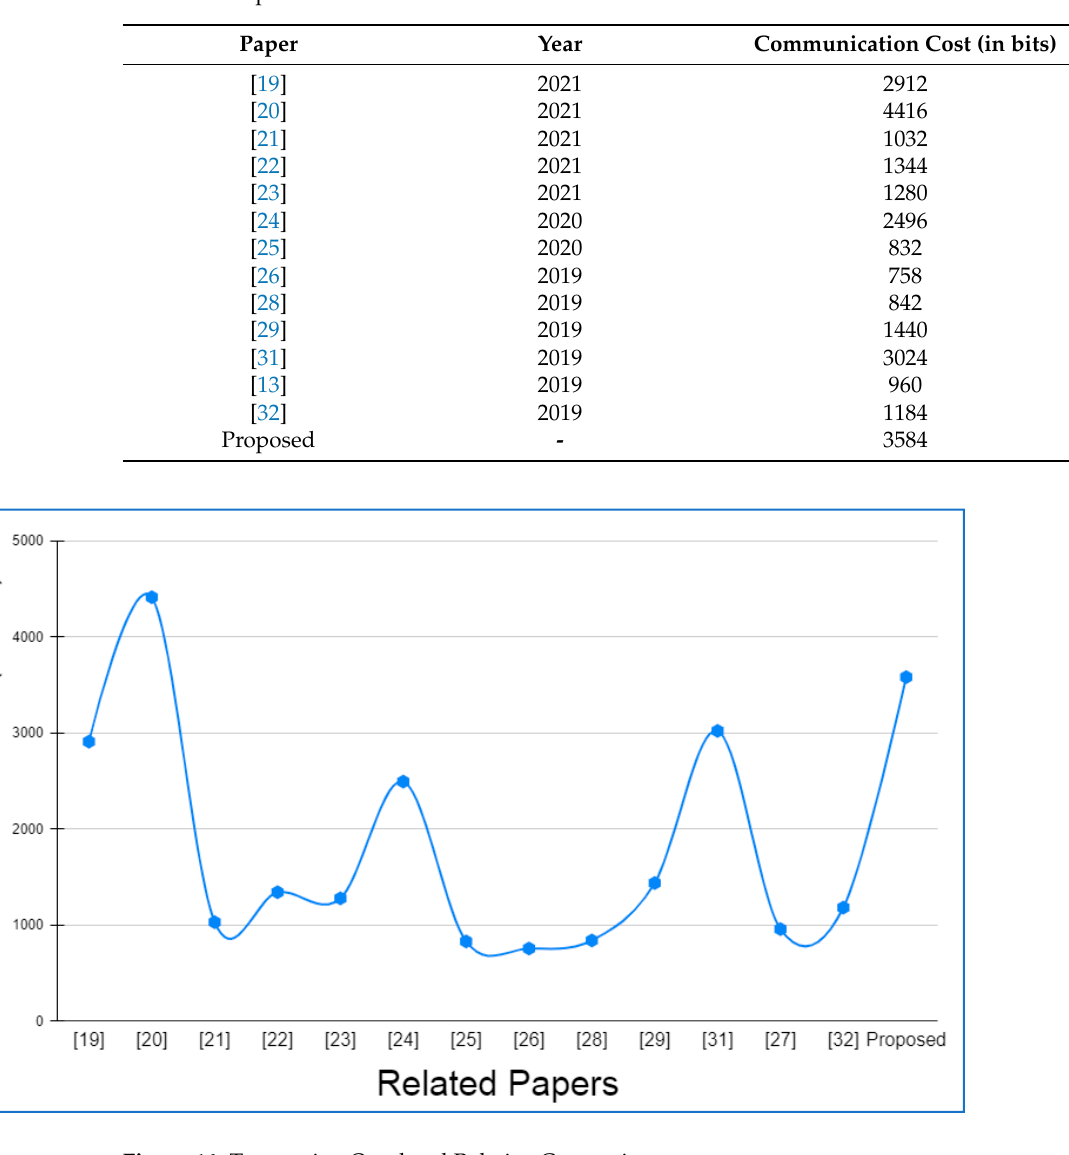
Table 9. Comparison of Transaction Overhead.